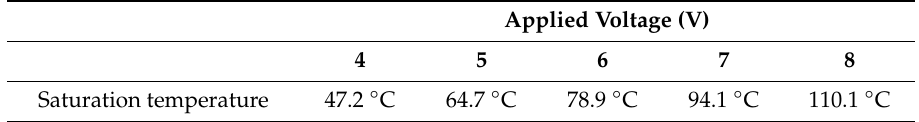
Table 1. Saturation temperature of Ag NW-based thin film heater (TFH) as a function of input